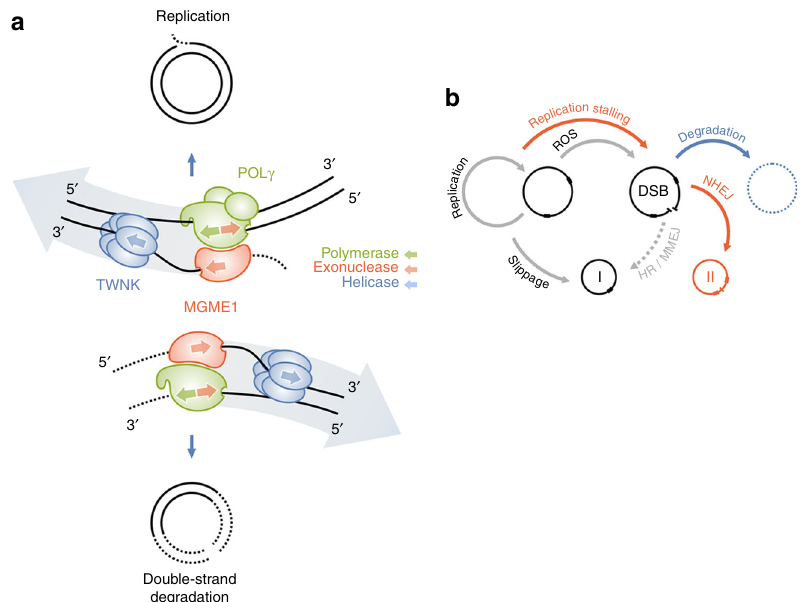
Fig. 6 Models of double-strand degradation of mtDNA and its role in generation of rearrangements. a POLG, TWNK, and MGME1 play a role in both replication (upper half of the panel) and degradation (lower half of the panel) of mitochondrial DNA. Upon replication, the net movement of the complex (indicated by the large shaded arrow) corresponds to the polymerase activity of POLG. Under these conditions, MGME1 can remove fl ap structures, thus creating ligatable ends 9 . During degradation, net movement is reversed and corresponds to the exonuclease activity of POLG. b Proposed role of linear mtDNA degradation in generation of rearrangements. Since double-strand breaks (DBS) are ef fi ciently removed in normal tissues (blue), most somatic mtDNA deletions are generated by replication slippage 25 , and thus are typically associated with direct repeats (black boxes) around the breakpoints ( ‘ I ’ , class I type of mtDNA deletions, Table 1). Repair by homologous recombination (HR) or microhomology-mediated end joining (MMEJ) is not an ef fi cient pathway in animal mitochondria 34 . In the case of replication machinery dysfunction (red), frequent replication stalling leads to increased generation of double-strand breaks (DSB). Additionally, the breakdown of linear mtDNA is inhibited. The persistence of linear mtDNA favors the formation of class II deletions ( ‘ II ’ ) by ligase-III-dependent non-homologous end joining (NHEJ). Supporting this hypothesis, an increased frequency of class II mtDNA deletions (not being associated with direct repeats) is observed in patients carrying pathogenic mutations in MGME1 , TWNK , and POLG (Table 1)